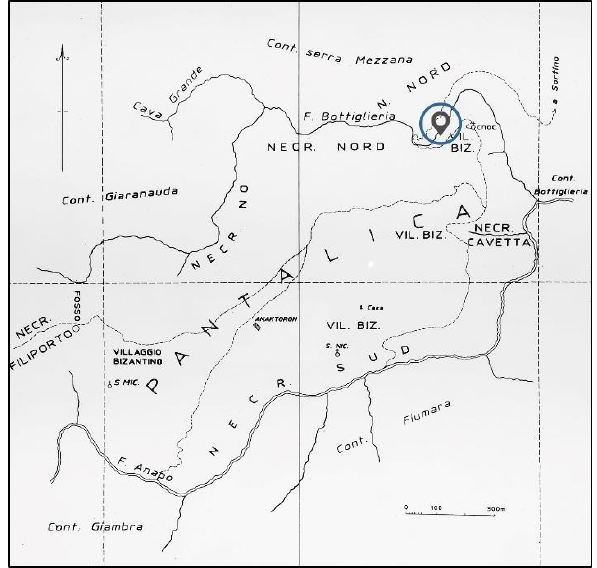
Figure 1. Map of “Pantalica, Valle dell’Anapo e Torrente Cava Grande” Nature Reserve and location of Grotta dei Pipistrelli